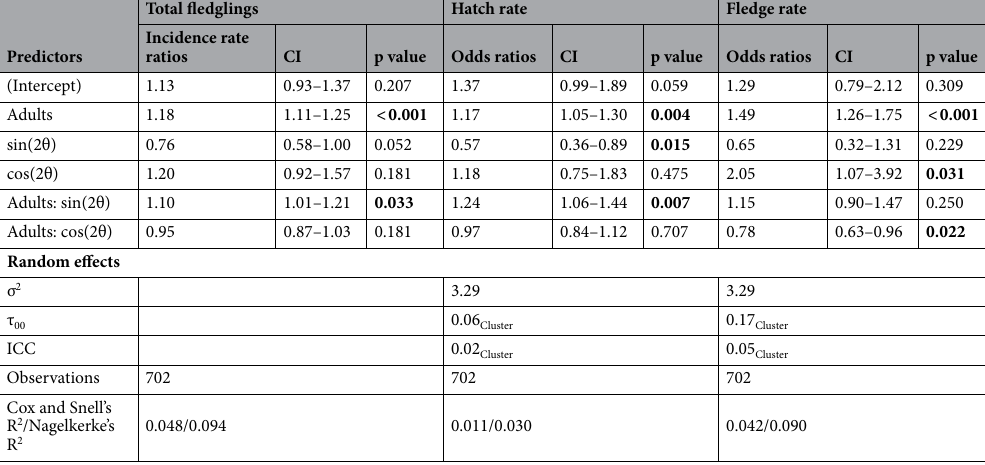
Table 2. Generalized linear and mixed effects models showing main and interactive effects of breeding group size (number of adult birds) and nest cavity direction on breeding success. Nest direction is represented by θ for the angular direction of the nest in radians. The total number of fledglings was modeled by GLM assuming a Poisson error distribution. Hatch rate and fledge rate were modeled by binomial GLMM. Significant values are in